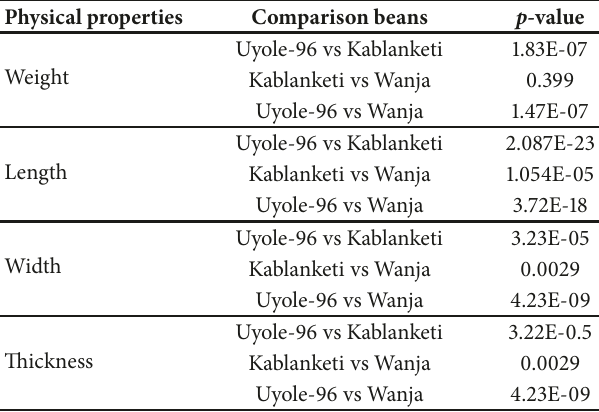
Table 3: Physical measurements comparison using ANOVA. Physical